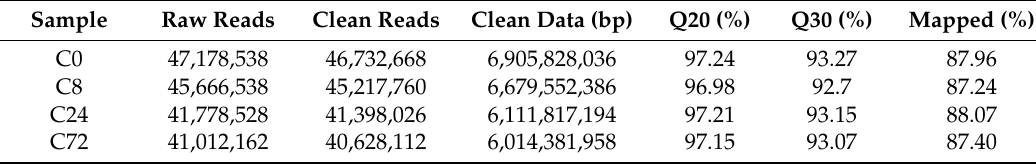
Table 1. Summary of sequencing data obtained in this study.